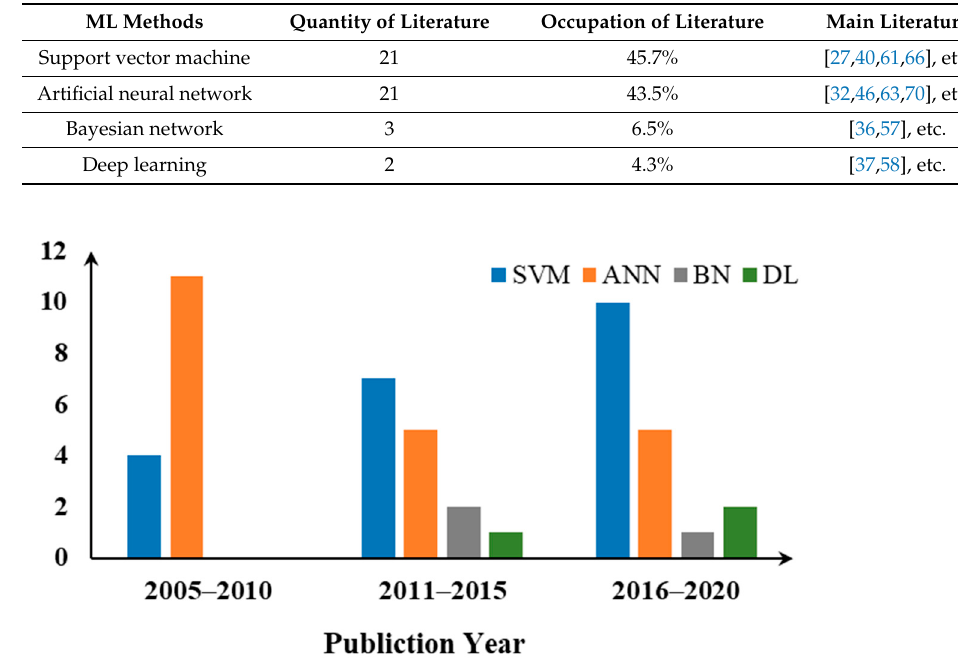
Figure 5. Trends of application of each ML method in literature over years.